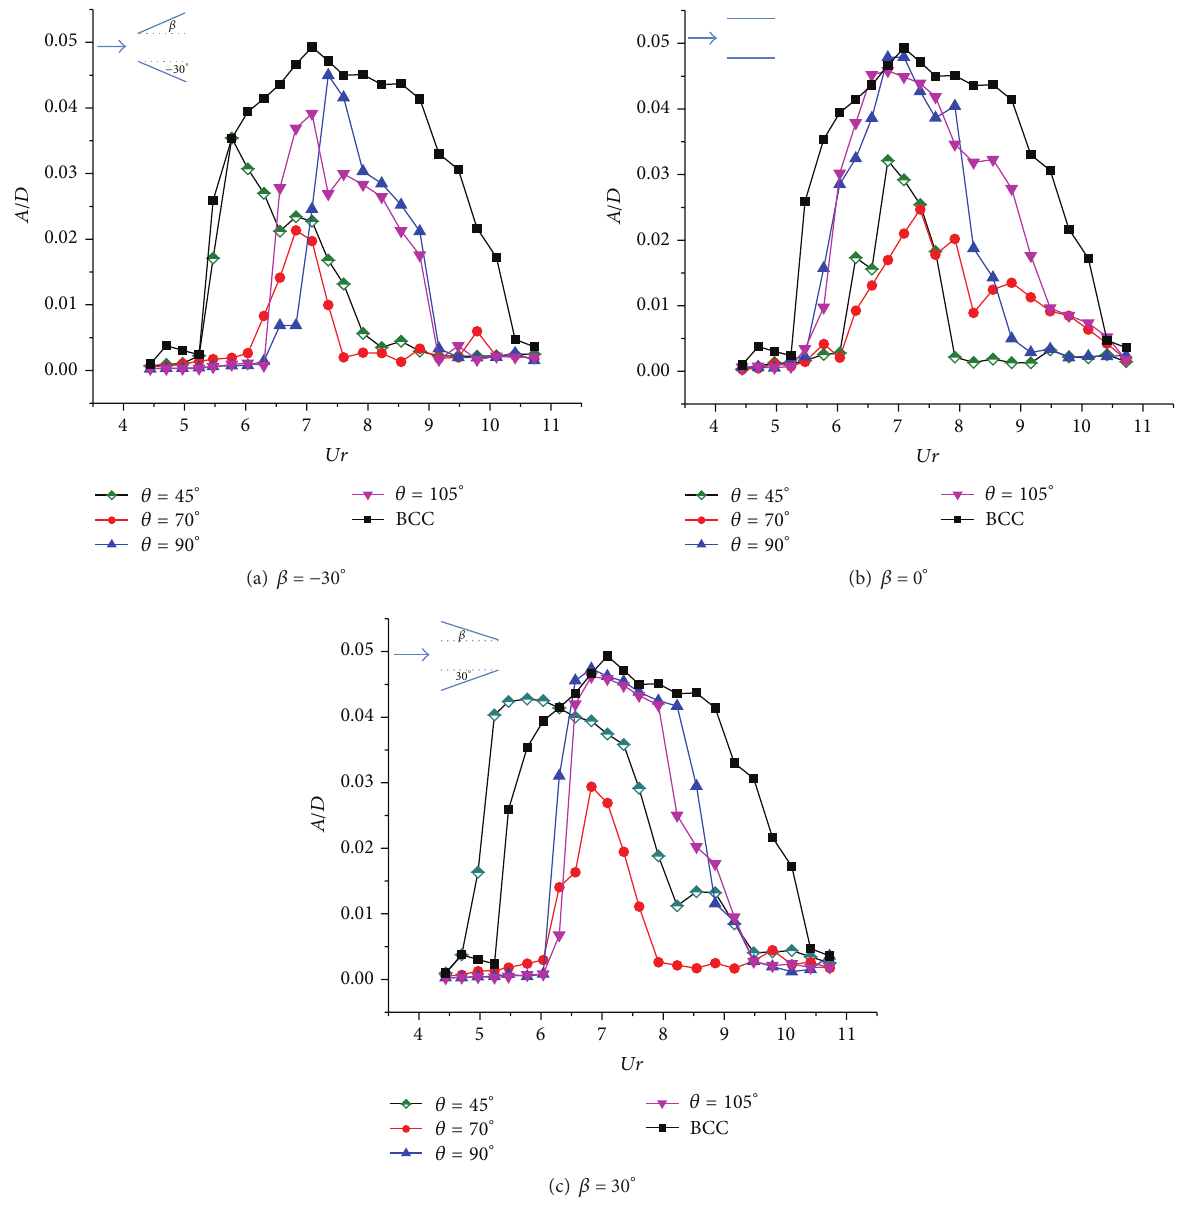
Figure 8: Displacement